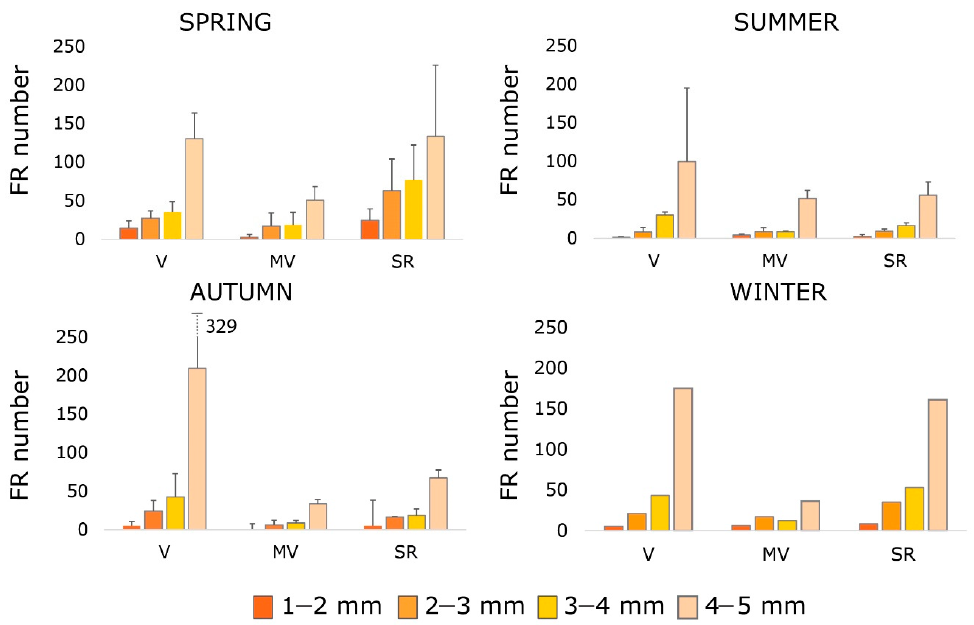
Figure 5. Seasonal analysis of the trend of the different size classes of fragments in the three sampled sites. In winter only one sampling was carried out, therefore there are no values for the standard deviation (data available in Table S4, Supplementary Material).